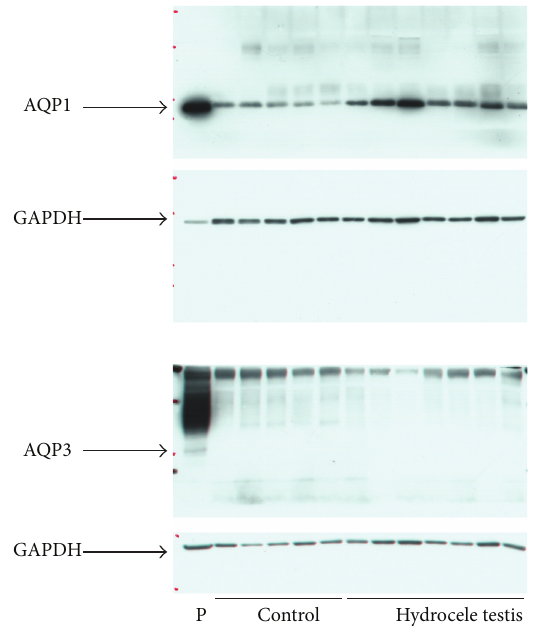
Figure 1: Expression of AQP1 and AQP3 proteins in the tunica vaginalis. P: human kidney tissue as a positive control for AQP1 and AQP3; ages of hydrocele patients: 57–84 years (median: 73); ages of control patients: 75–82 years (median: 78).